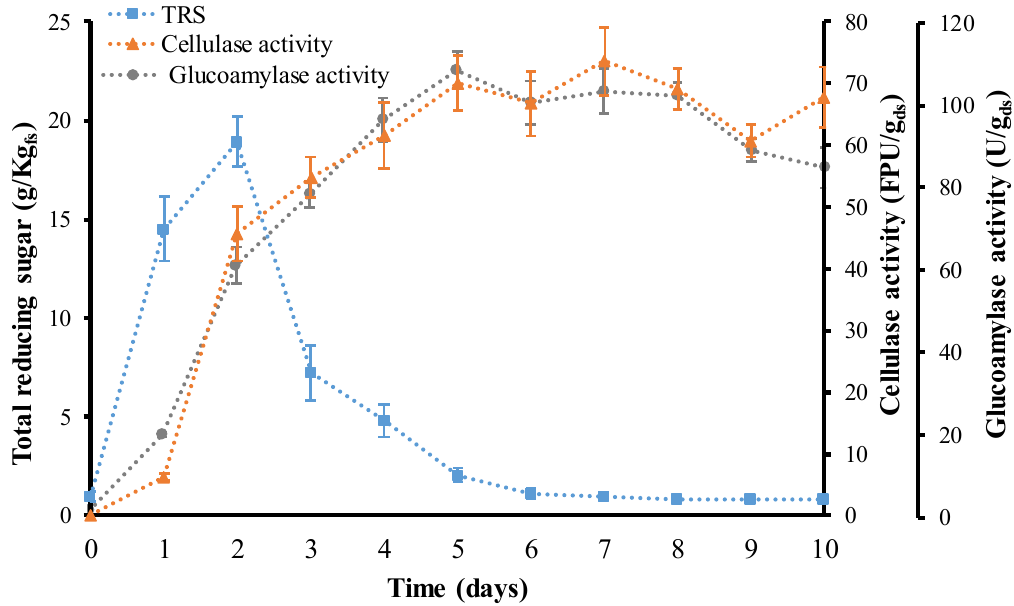
Figure 3. Total reducing sugar (TRS), cellulase and glucoamylase activity during 10 days of fermentation. Square represents total reducing sugars. Triangle represents cellulase activity, and the circle shows glucoamylase activity.